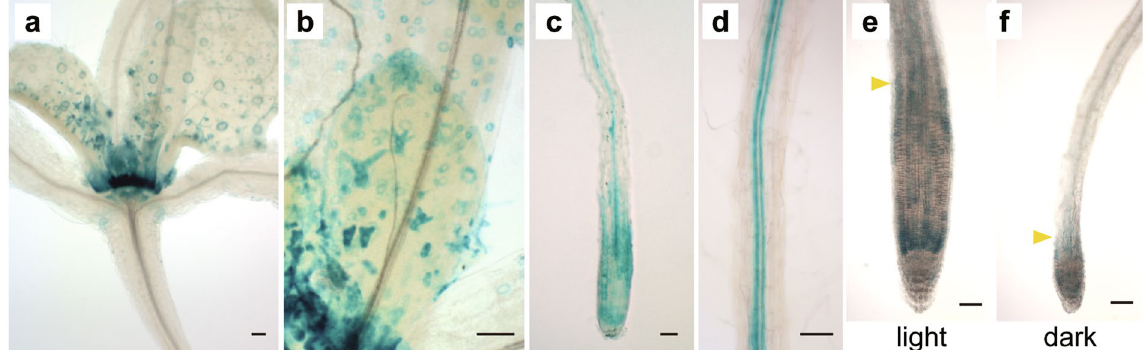
Figure 2. DWF4-GUS expression pattern. ( a ) High expression levels in the shoot apical meristem and surrounding region. ( b ) Expression levels in guard cells and developing trichomes. Expression levels in the root apex and young central cylinder ( c ) as well as the central cylinder ( d ) DWF4-GUS expression levels in roots under light ( e ) and in darkness ( f ) as determined by differential interference contrast microscopy. Arrowheads indicate the borders between the cell division and elongation zones. Scale bars represent 50 µ